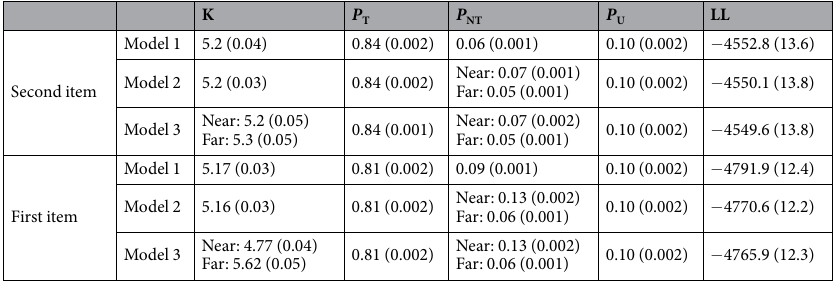
Table 3. Estimates from the mixture models for Experiment 2, calculated using a model in which neither K nor P NT could differ between Near and Far conditions (Model 1), a model in which only P NT could differ (Model 2) and a model in which both K and P NT could differ (Model 3). The 95% confidence interval is shown in parentheses, which was found by bootstrapping the data 100 times. LL denotes the log